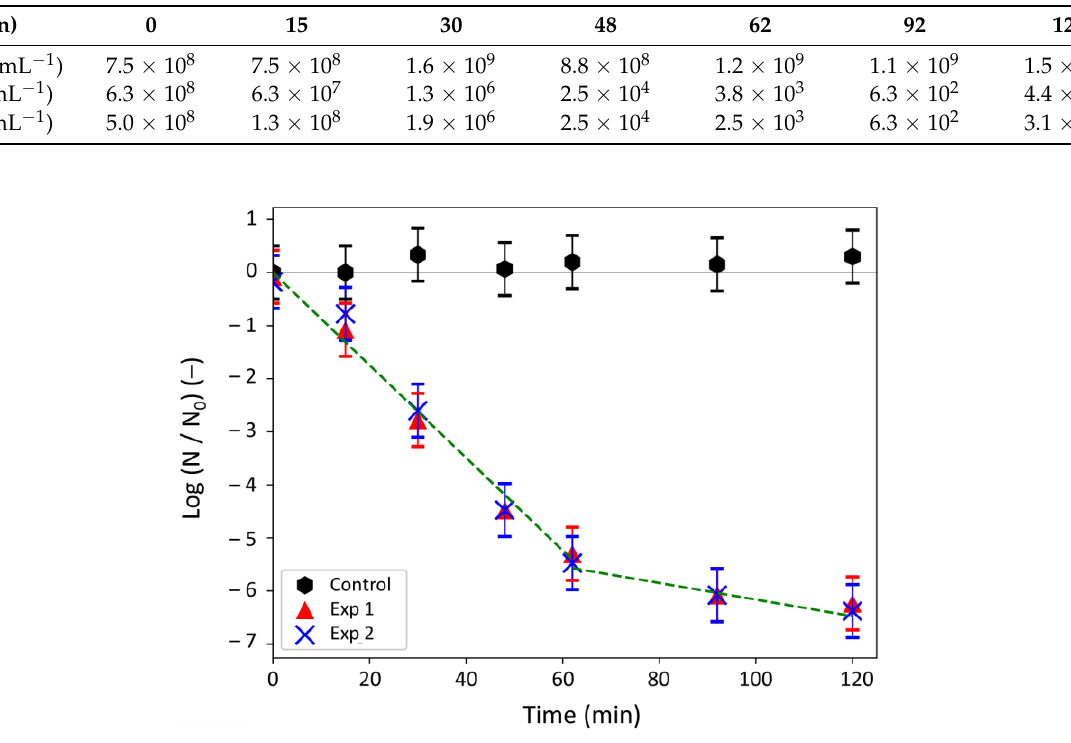
Figure 4. Log-removal values measured over time for silver ions against E. coli bacteria. N 0 refers to the initial bacterial concentration and N to the bacterial concentration at a given time.